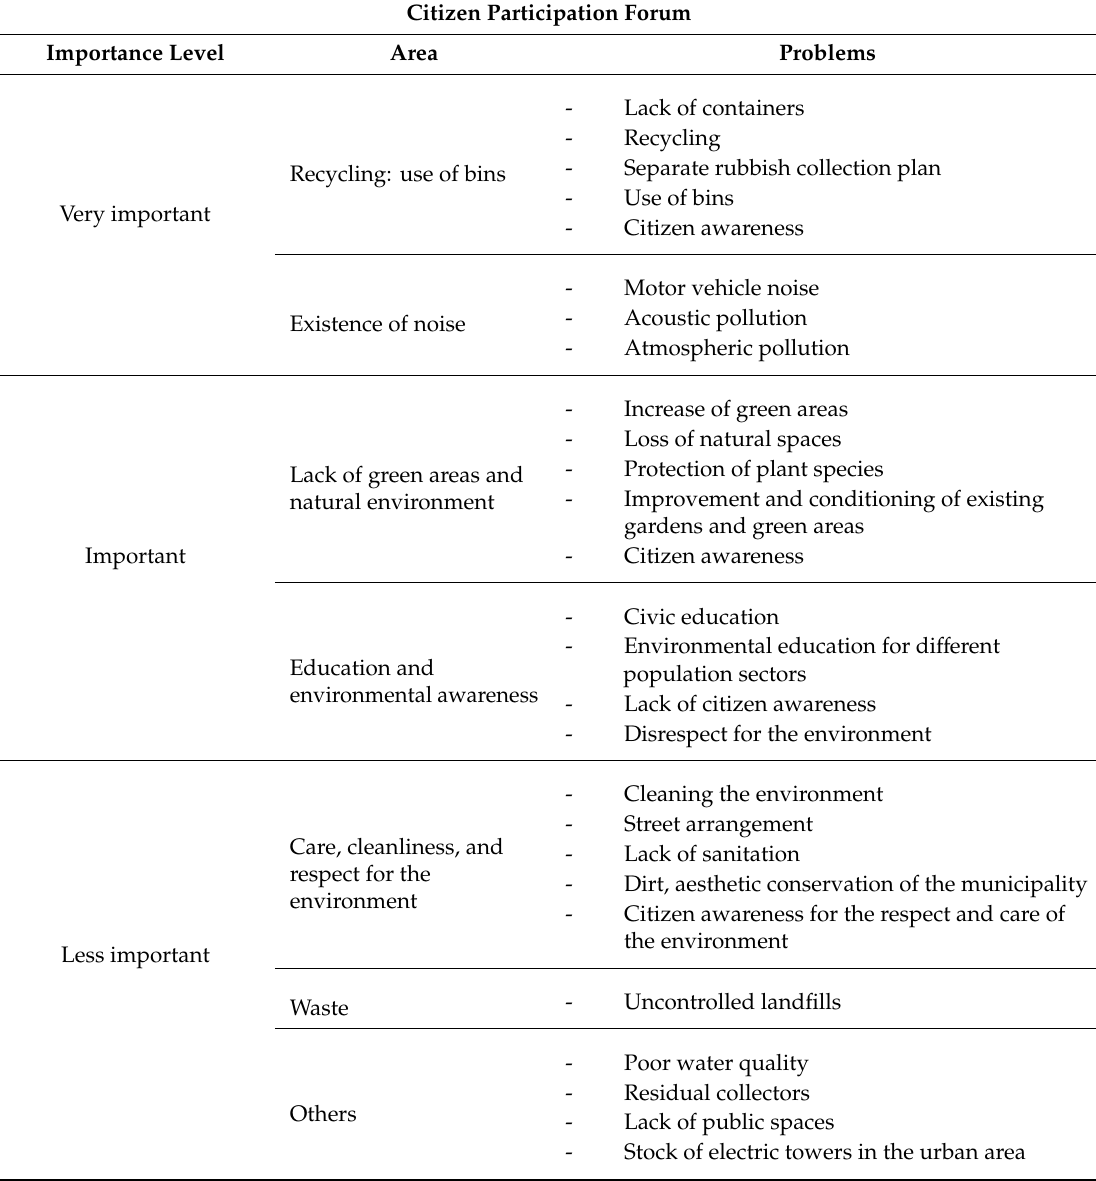
Table 13. Socio-environmental problems extracted from the citizen participation